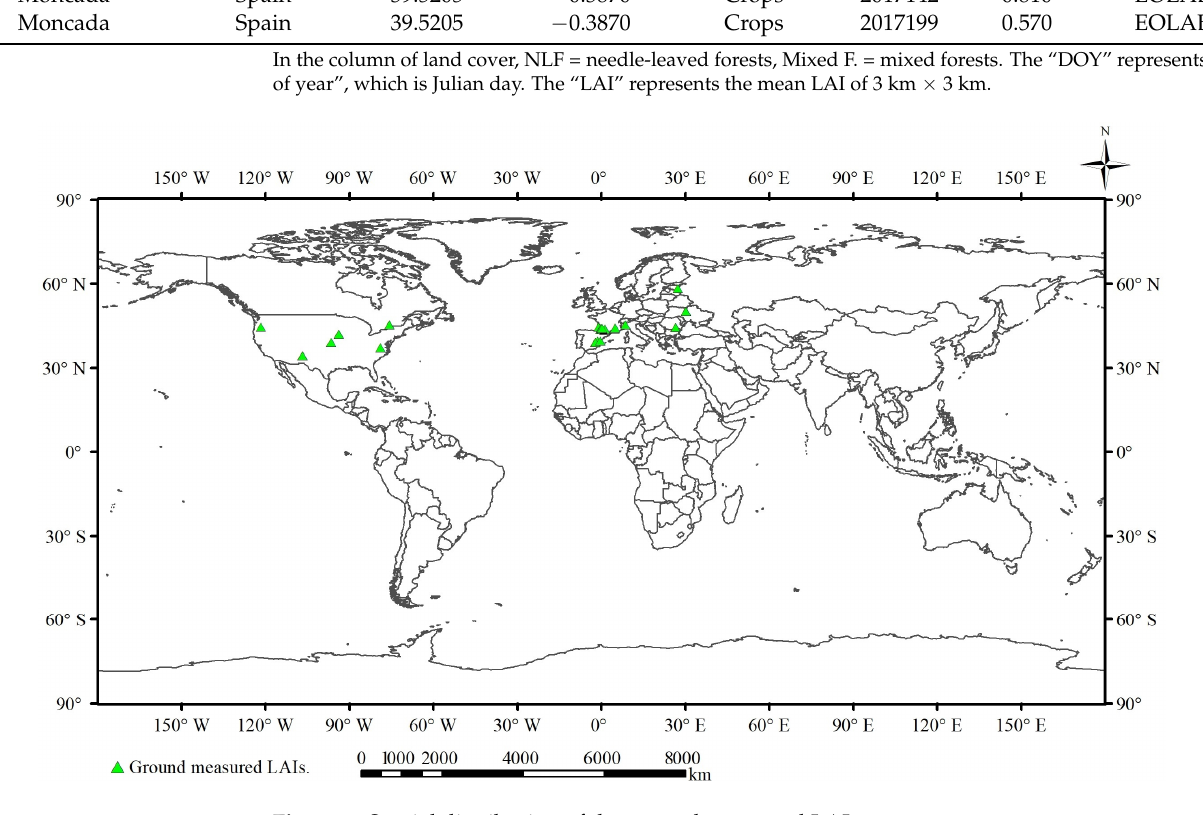
Figure 2. Spatial distribution of the ground-measured LAI.